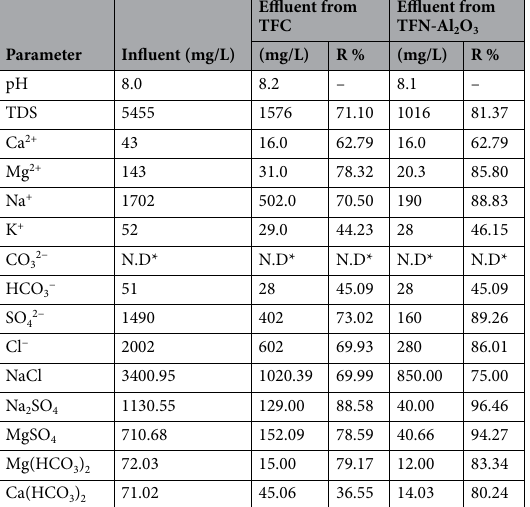
Table 2. Treatment efficiency of the different membranes for real brackish water. * N.D Not